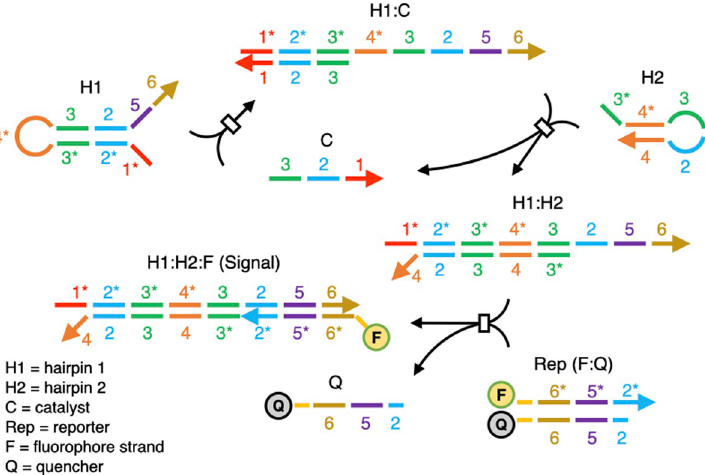
Fig 4. Reaction diagram of catalytic hairpin assembly. In this diagram, domains (short sequence segments) are indicated by number. Asterisks indicate sequence complements. Complexes of multiple strands are denoted with a colon. Key assemblies of strands are shown, while intermediate complexes involved in strand exchange and displacement reactions (e.g. domain 1 binding to domain 1 � between C:H1, invasion of domains 2 and 3 on C into the H1 stem region, and unfolding of H1 by dissociation between the domains comprising the stem) are omitted (represented as boxes). Single-stranded catalyst (C) binds to Hairpin 1 (H1) via the single-stranded domain 1, and can initiate strand exchange and displacement with domains 2 and 3. The newly exposed single-stranded domain 3 then binds to the partially single-stranded domain 3 � on Hairpin 2 (H2), again resulting in strand exchange and displacement, ultimately yielding H1:H2 (which is more stable than H1:C). The displaced C strand becomes available to catalyze another reaction. The reaction can be followed via a hemi-duplex reporter (Rep) where strand exchange and displacement of a fluorescent oligonucleotide conjugate from a quenching oligonucleotide conjugate is initiated by binding of domain 2 in the H1:H2 product.